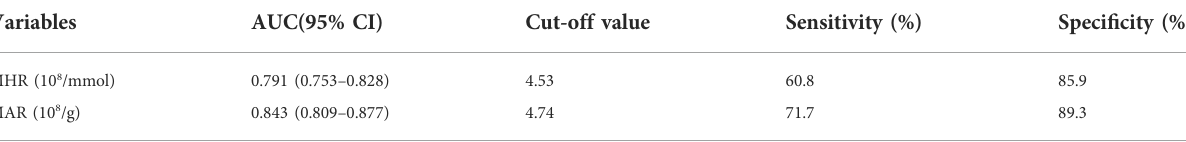
TABLE 6 ROC Curve Analysis of MHR and MAR in identifying osteoporosis.